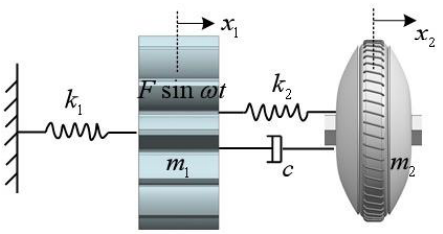
Figure 5. Dynamic vibration-absorption model of face-gear honing.